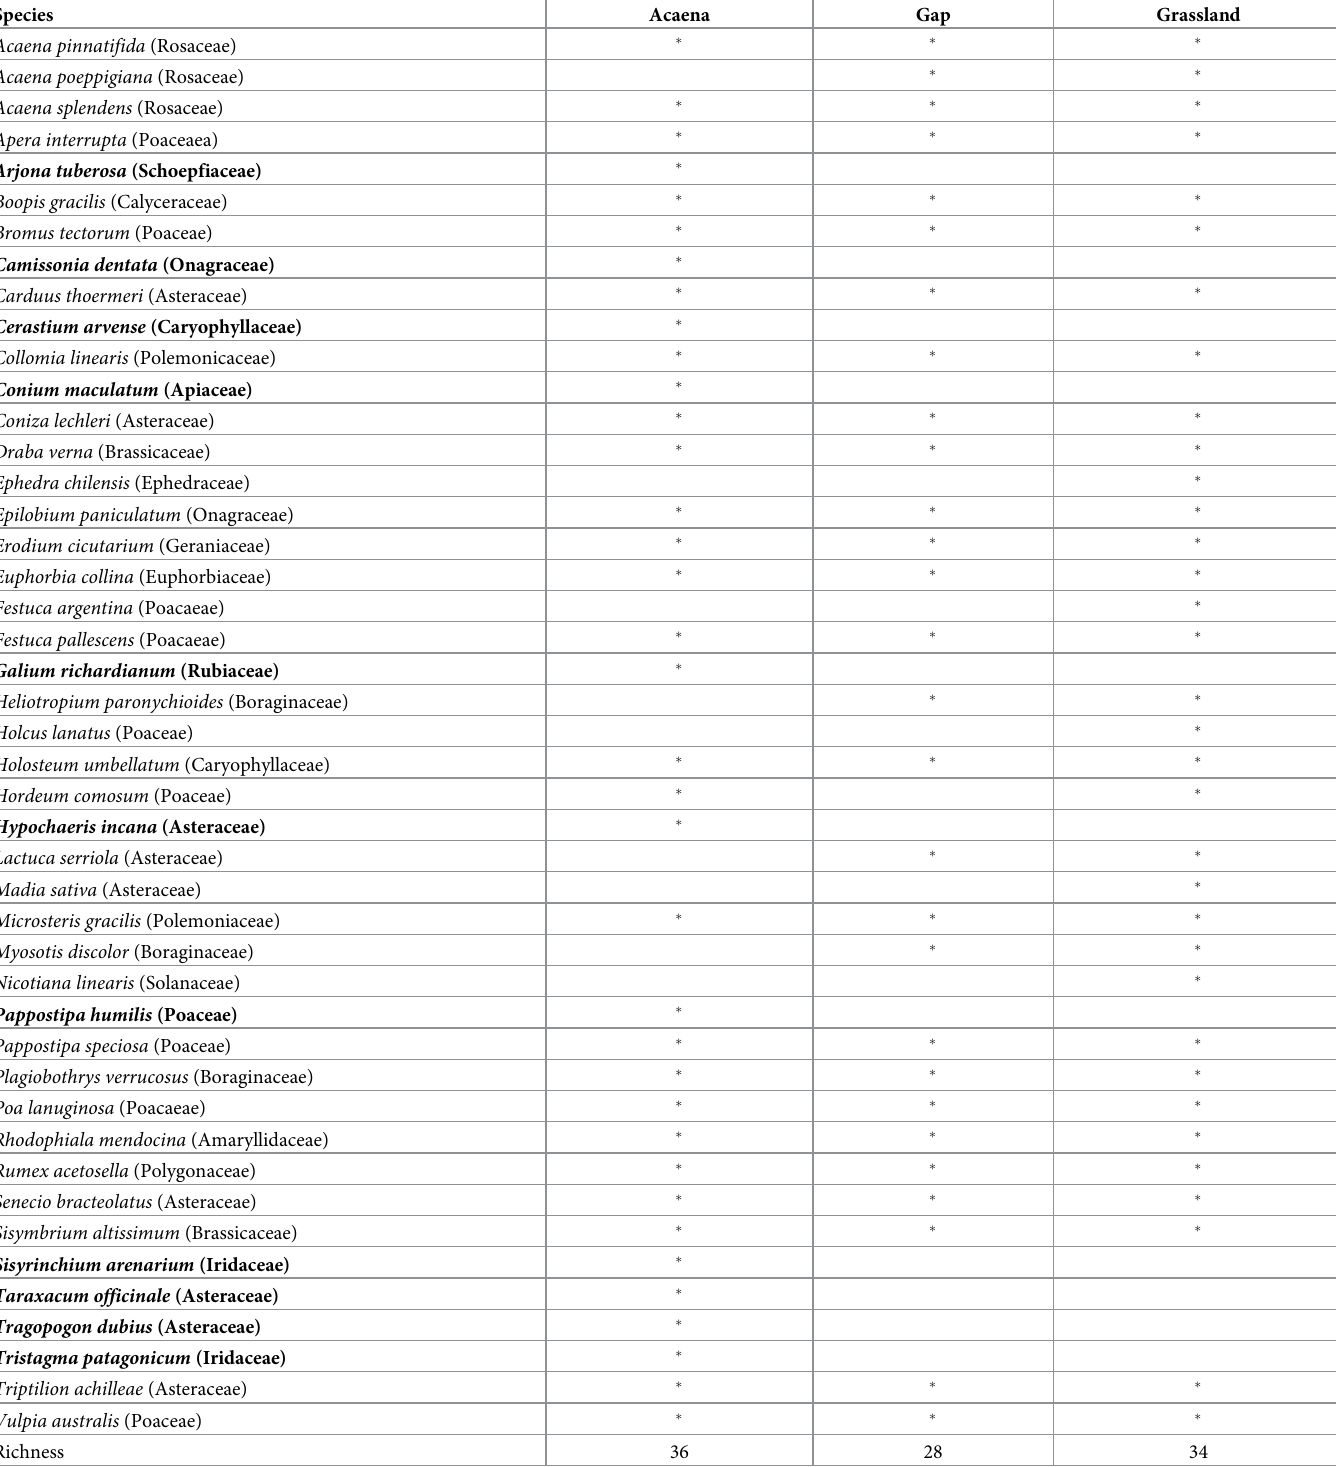
� Indicates presence of the species. Species highlighted in bold are exclusive to A . splendens senescent plants.